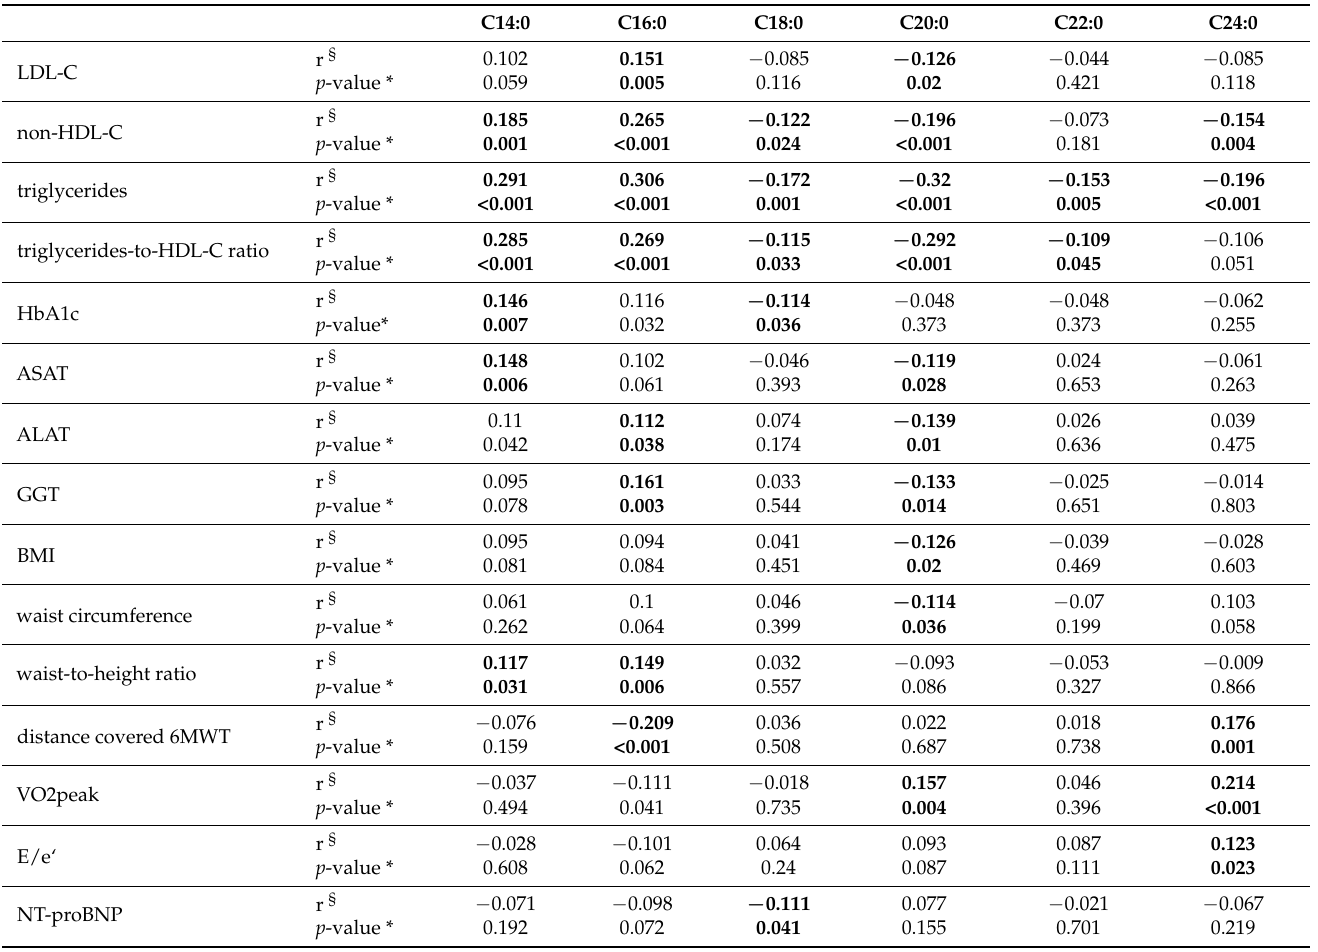
Table 3. Associations between individual SFA and patient characteristics at 12